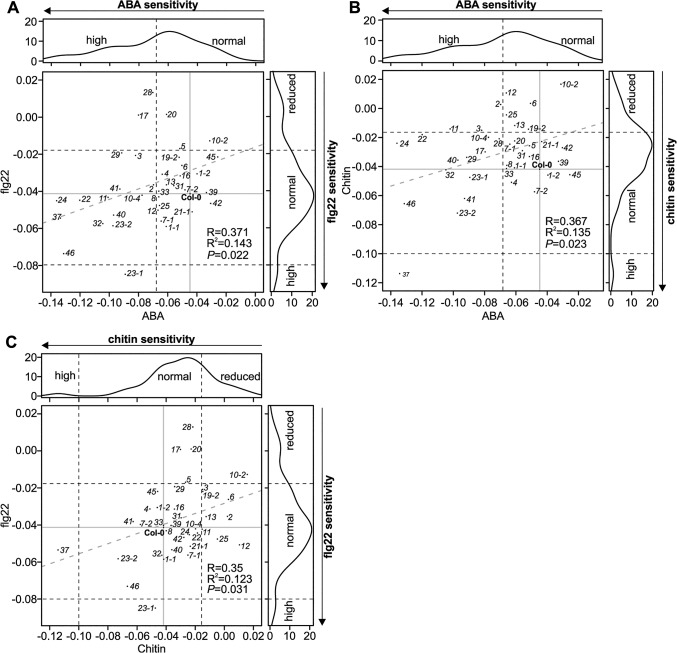
Scatter plots for stomatal regulation in crk mutants.
(A) Scatter plot of stomatal responses of crk mutants to ABA (x-axis) and flagellin (flg22; y-axis). (B) Scatter plot of stomatal responses of crk mutants to ABA (x-axis) and chitin (y-axis). (C) Scatter plot of stomatal responses of crk mutants to chitin (x-axis) and flg22 (y-axis). Black dashed lines indicate the cut-off for reduced, normal, and high response with respect to Col-0. Grey dashed lines show regression fit with correlation (R), coefficient of determination (R2) and significance reported in lower right corner in each plot. Reduced or increased responses were statistically significant in the majority of mutants (see respective barplots in S15A and S23 Figs).